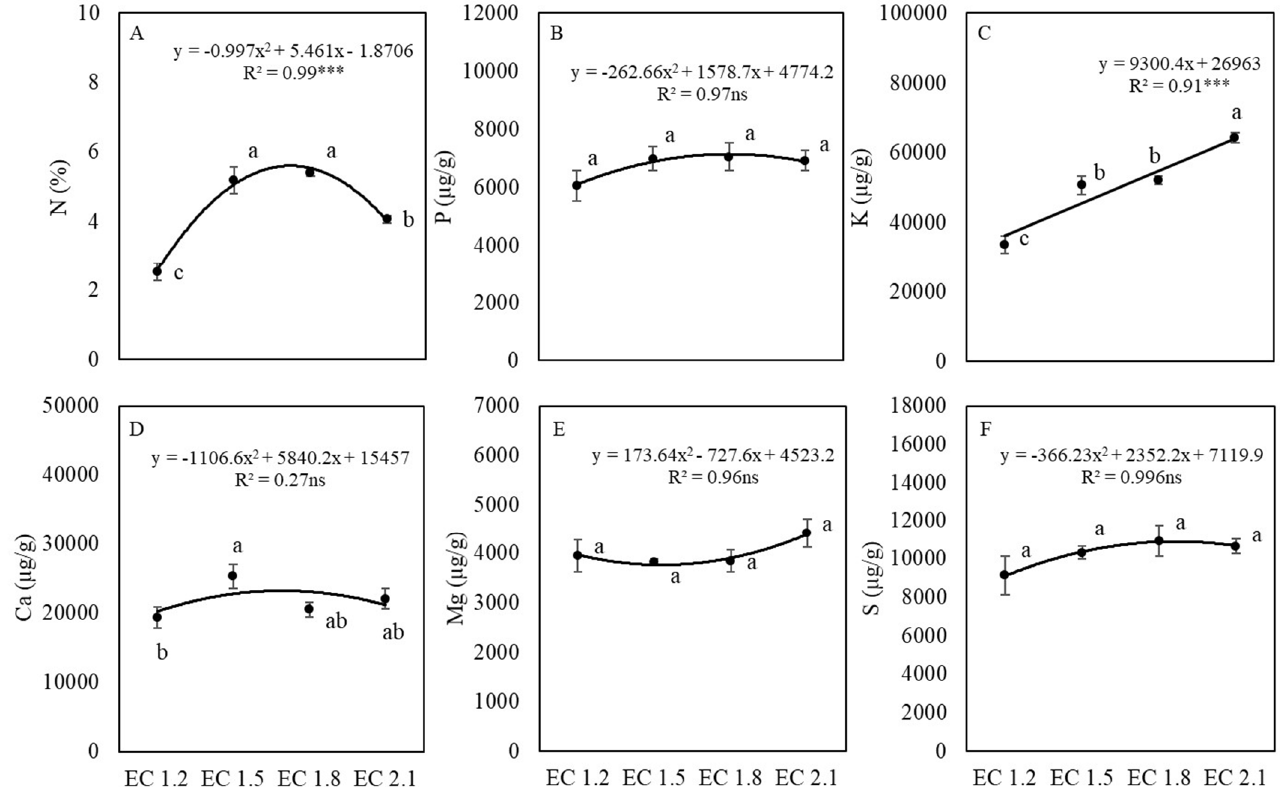
Figure 8. Effect of electrical conductivity (EC) of nutrient solution on arugula macro nutrition content including: ( A ) nitrogen, ( B ) phosphorus, ( C ) potassium, ( D ) calcium, ( E ) magnesium, and ( F ) sulfur in the shoot part of arugula 4 weeks after transplanting into a nutrient-film technique hydroponic system containing nutrient solutions with EC of 1.2, 1.5, 1.8, or 2.1 dS·m − 1 . Data points with different letters are significantly different according to Tukey’s test ( α = 0.05). Error bars represent the standard errors ( n = 32). ns or *** indicate no significance or significance at P of 0.001.